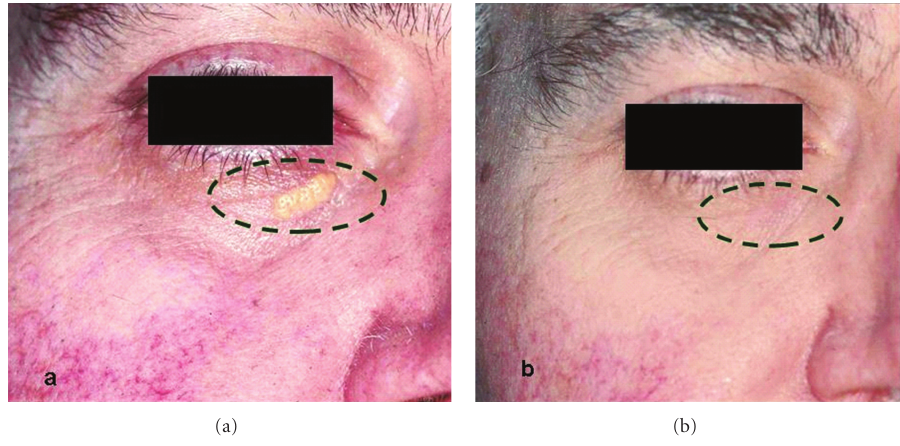
Figure 8: Xanthelasma at first (a) and after (b) one treatment with CO 2 laser.